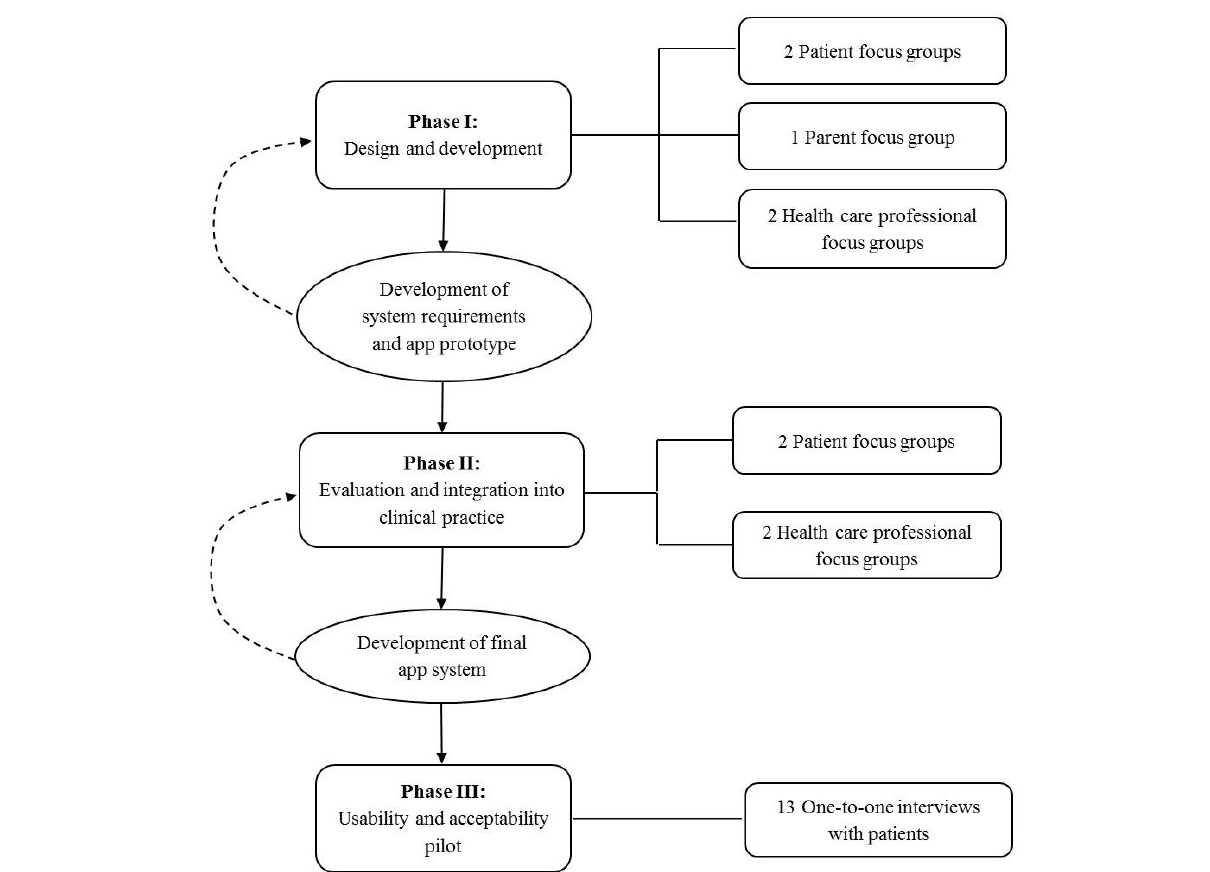
Figure 1. Study phases and iterative development